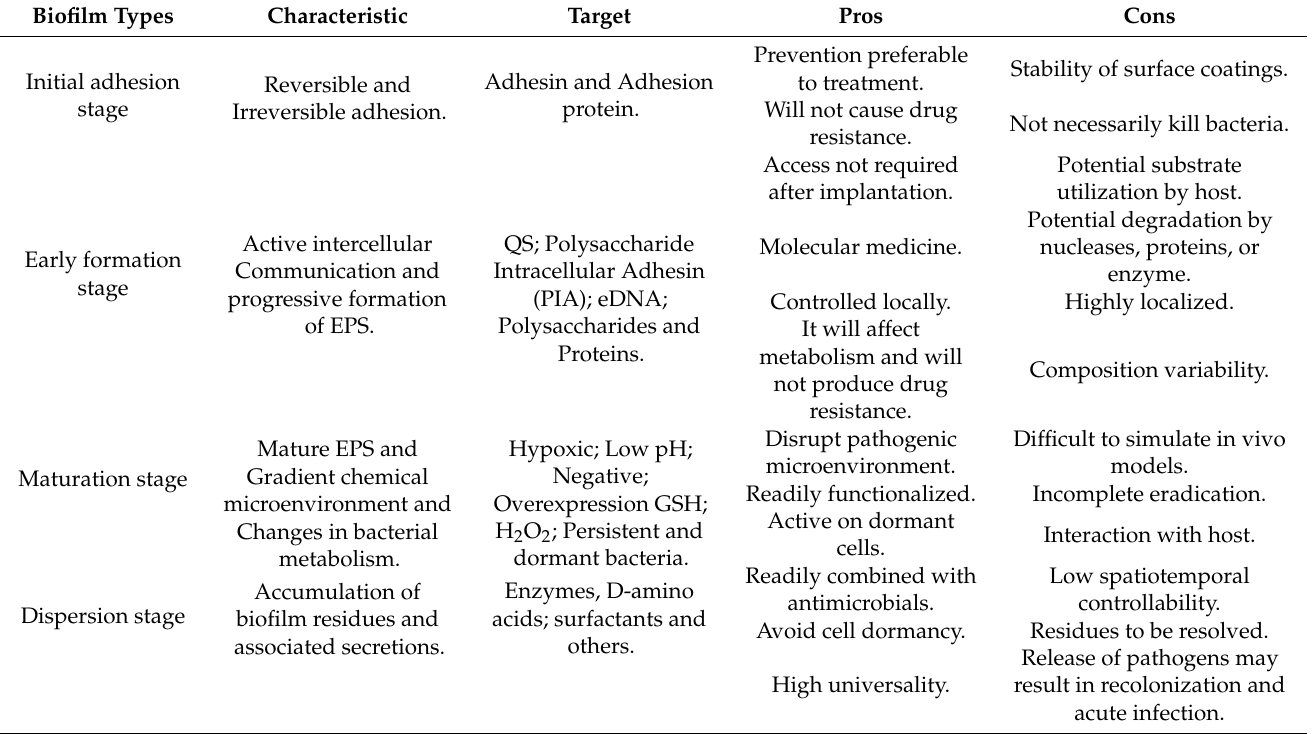
Table 1. Characteristics, targets, and targeting advantages of biofilm at different